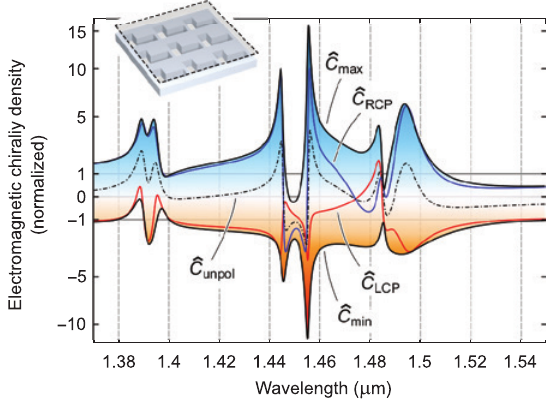
Figure 3: Simulated electromagnetic chirality density ˆ C